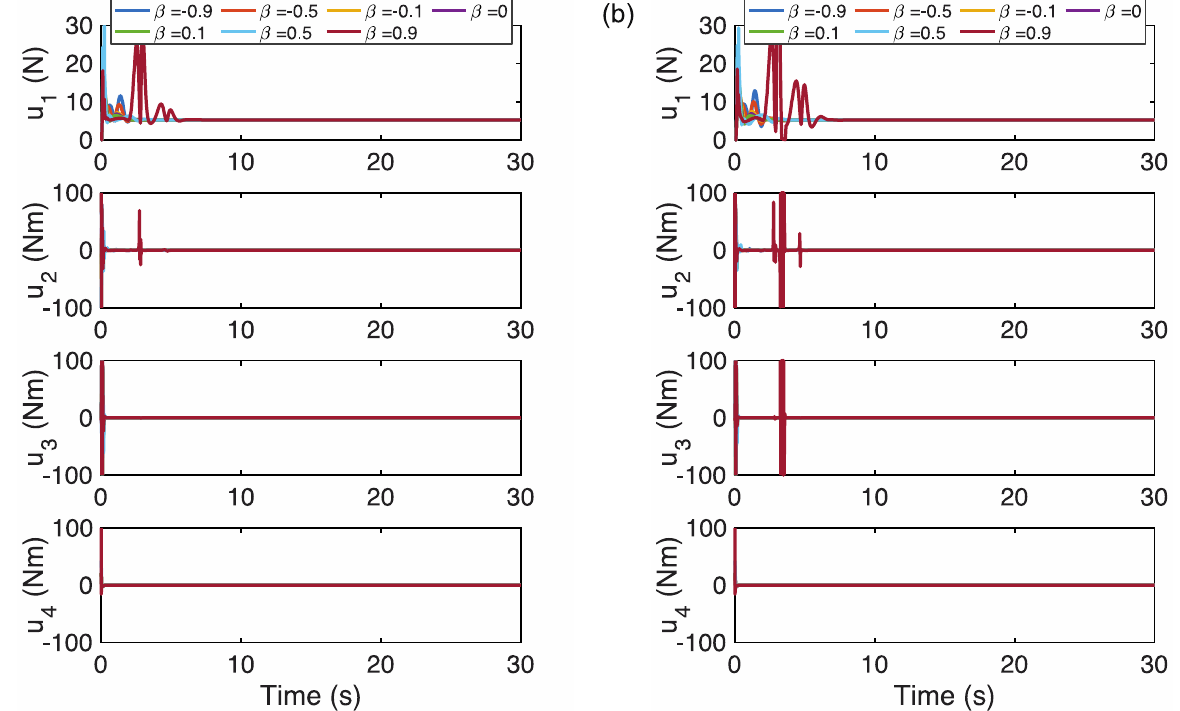
Figure 6. Simulated control inputs of the varying fractional orders in the proposed controller to various input delays: ( a ) τ = 0.05 s, ( b ) τ = 0.1 s. (Assume that τ = τ 1 = τ 2 = τ 3 = τ 4 and no